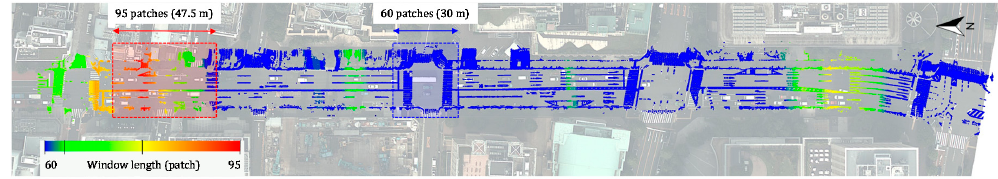
Figure 26. Length of the dynamic sliding window for survey No. 6